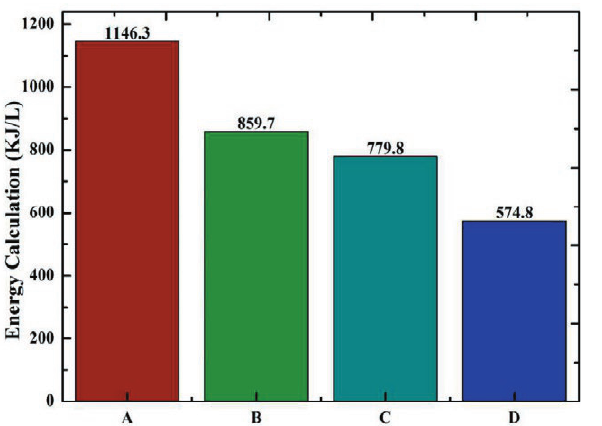
Figure 6. Comparison of thermal energy cost using air as carrier gas; A indicates energy cost at 150 °C inlet gas temperature using 2 m AB solution; B shows at 150 °C inlet gas temperature with 1 m AB solu- tion; C illustrates at 150 °C inlet gas temperature with 0.5 m AB solu- tion and D explains energy cost at 275 °C using 2 m AB